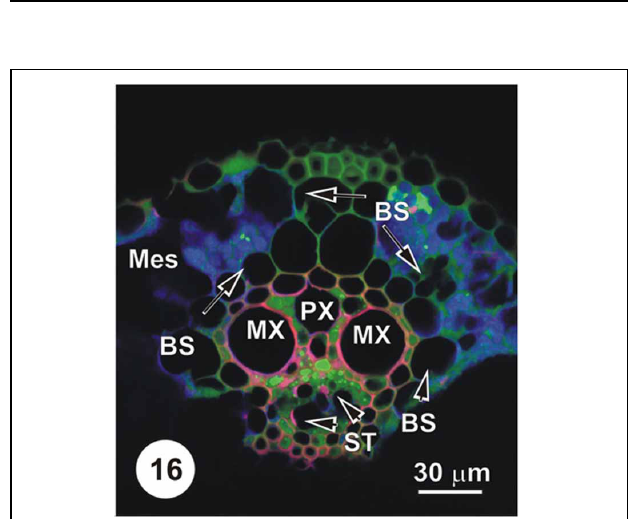
FIGURE 16 | LSCM imaged transections through a small (Figure 14), an intermediate (Figure 15) and a large (Figure 16) longitudinal bundles, showing distribution of 5,6-CF, after uptake of 5,6-CFDA (green fluorescence) co-transported with propidium iodide (red fluorescence; PI stains lignin and cellulosic walls) after 45min uptake and 6cm above the cut end of a rice leaf blade [full methodology in Botha et al. (2008)]. Vascular parenchyma associated with the protoxylem (PX) contains 5,6-CF, as do cells immediately below the MX, where VP and TST contain 5,6-CF (green fluorescence). The ST and below these, large diameter early ST (arrowheads) contain no 5,6-CF. Note that some 5,6-CF is present in the hypodermal fibers associated with this vascular bundle. As is common in grasses, vascular bundles are surrounded by a bundle sheath (BS).